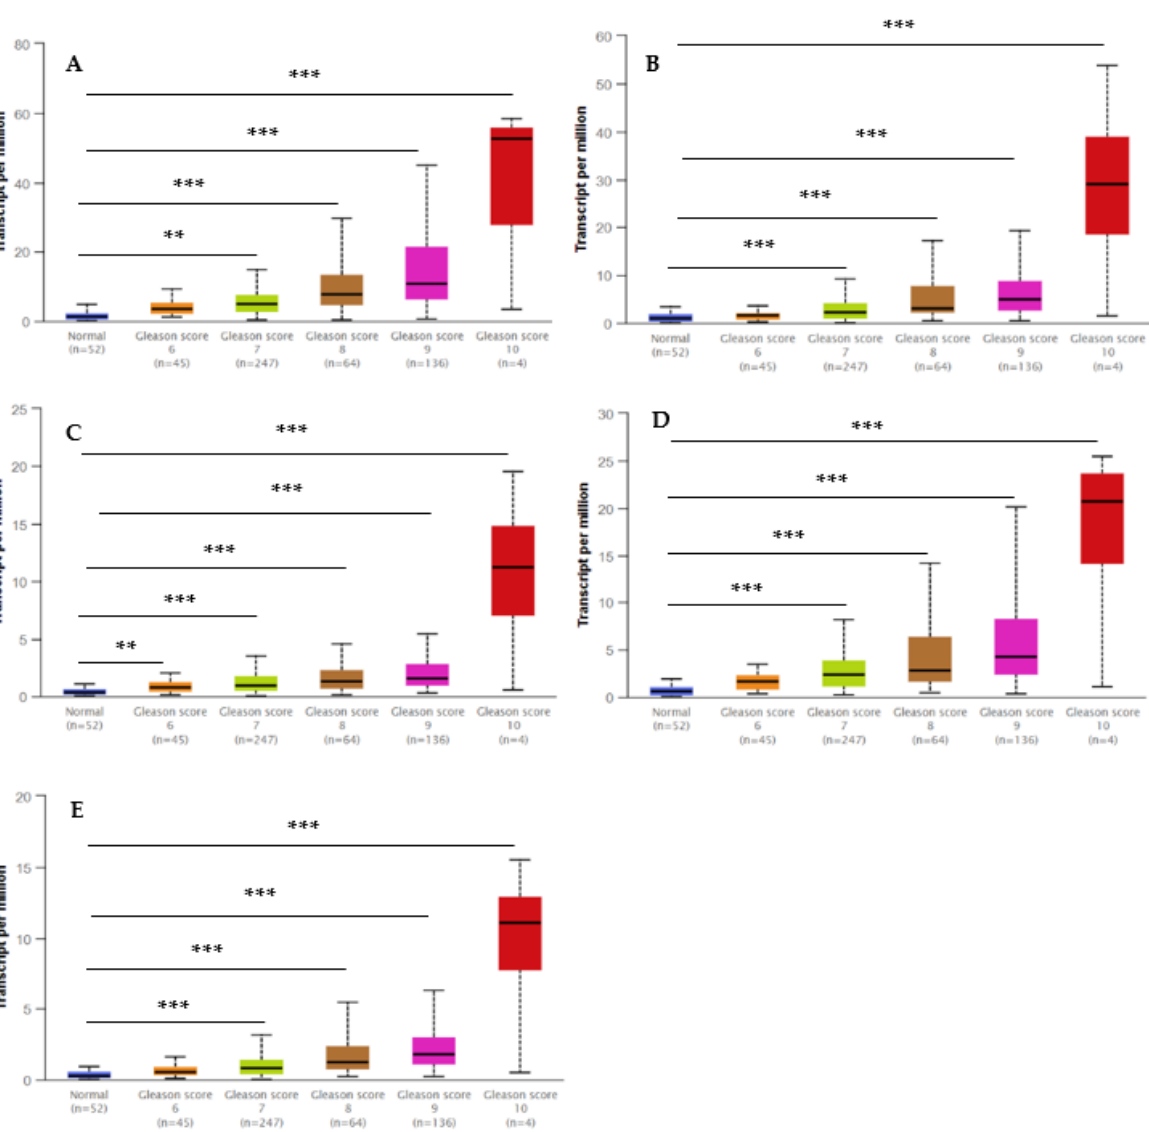
Figure 8. Box whisker plots indicating the expression of five hub genes in PCa samples. ( A ) UBE2C; ( B ), TOP2A; ( C ) BUB1B; ( D ) RRM2; and ( E ) CENPF were identified by MCODE and verified at the protein level by UALCAN, which came from the TCGA project. Data are mean ± SE. *** p < 0.001.